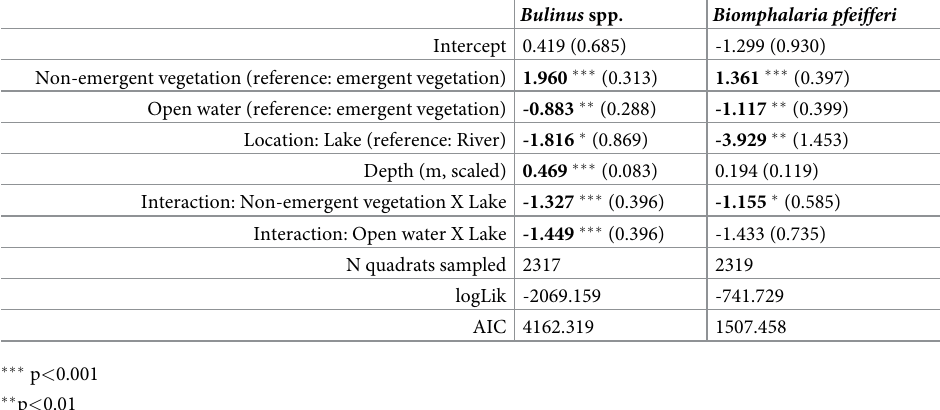
Table 1. Regression table for snail-habitat models (ZINB GLMM) of snail density (snail counts per sampling quadrat) in water access sites as a function of freshwater habitat type, water depth, and village location (lake vs. river), for both Bulinus spp. snails and Biomphalaria pfeifferi . Snails of both species were most abundant in non- emergent vegetation. In all habitat types, snails were less abundant in village water access sites on lake settings than those on river settings. The number of quadrats sampled differs due to missing data for Bulinus spp. snail counts in two quadrats. Coefficients for differences in snail density according to habitat type are shown for non-emergent vegeta- tion and open water with emergent vegetation as the reference category. Model coefficients are shows with standard errors in parentheses. Bolded coefficients represent statistically significant factors. � p < 0.05, �� p < 0.01, ��� p <